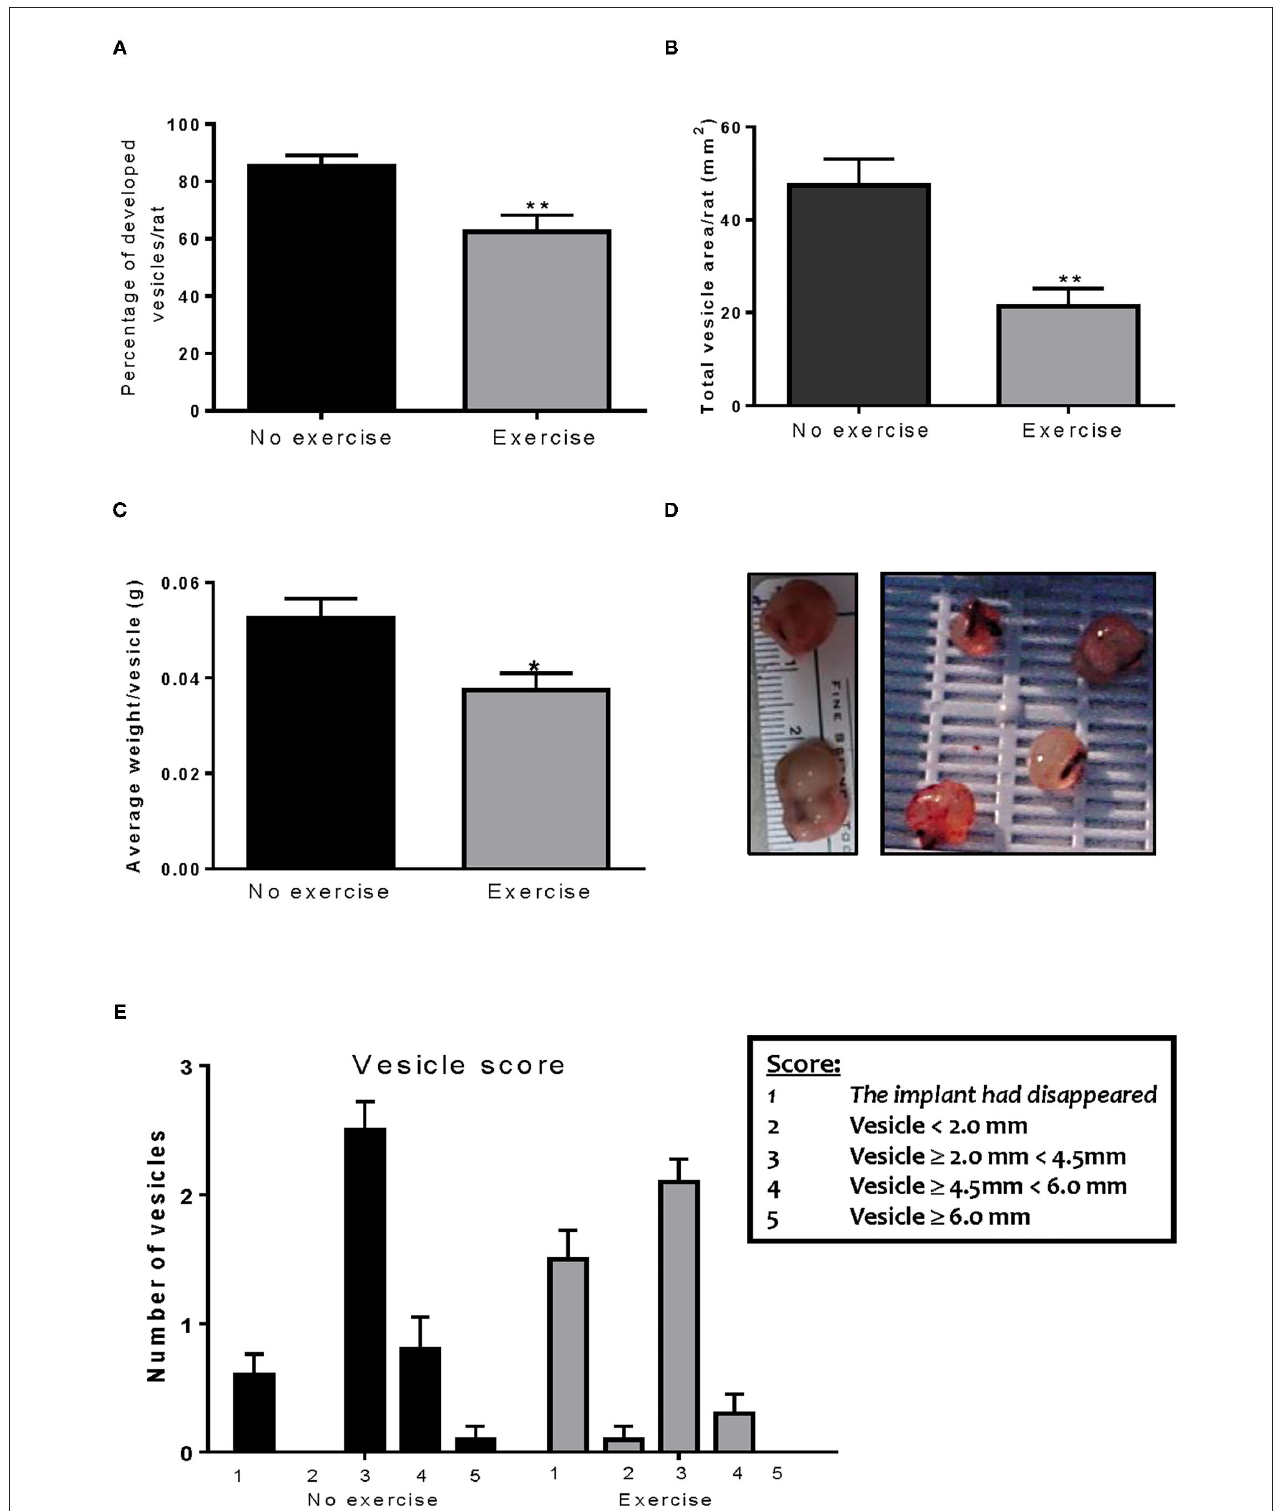
FIGURE 2 | Voluntary wheel running decreases implant size. (A) Exercise significantly decreased the percent of vesicles which developed in the endometriosis animals. (B) The Endo-Exercise animals had vesicles of a smaller area, which (C) weighed less than those found in the sedentary group. (D) Representative photos of lesions collected. (E) The Endo-Exercise animals developed significantly less vesicles and which were of a smaller size than the non-exercised group ( n = 10 animals/group ± sem * p < 0.5, ** p < 0.01).